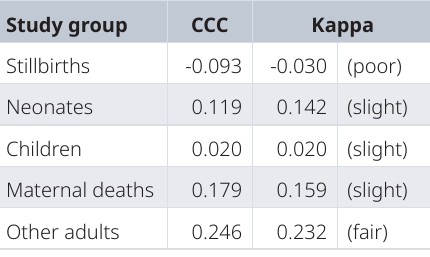
Table 2. Measures of performance of the InterVA (Interpreting Verbal Autopsy) model compared to the complete diagnostic autopsy at individual-level prediction for all causes of death by study